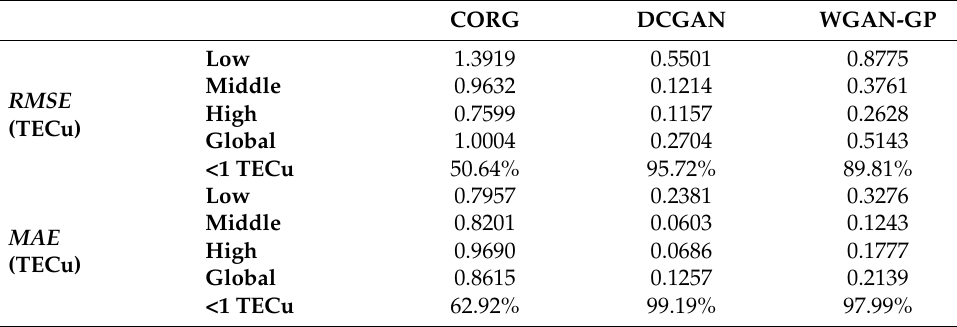
Figure 6. The RMSE and MAE for spatial TEC estimation in 2017. The 71 × 73 grids are interpolated with a spline to demonstrate a finer global feature of ionospheric TEC . Table 3. The mean values for RMSE and MAE in 2017.